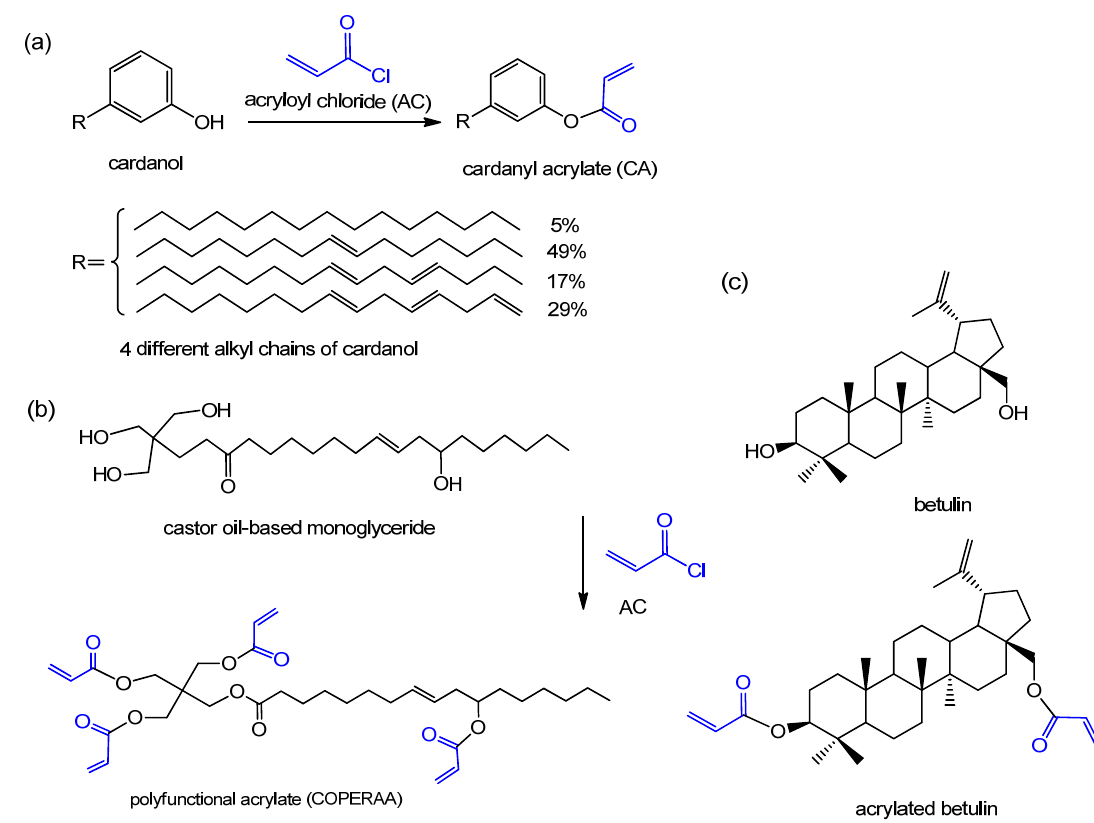
Figure 3. Synthesis routes of ( a ) CA, ( b ) COPERAA and ( c ) acrylated betulin from cardanol, castor oil and betulin with AC